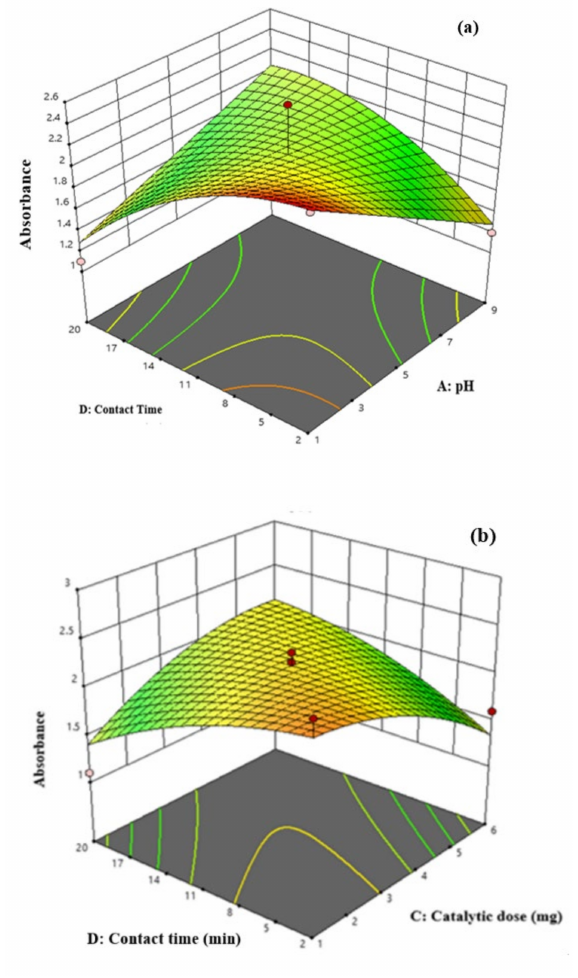
Figure 8. ( a ) Enzyme activity of nanocomposite (using catechol) as a function of contact time and pH. ( b ) Enzyme activity of nanocomposite (using resorcinol) as a function of contact time and catalytic